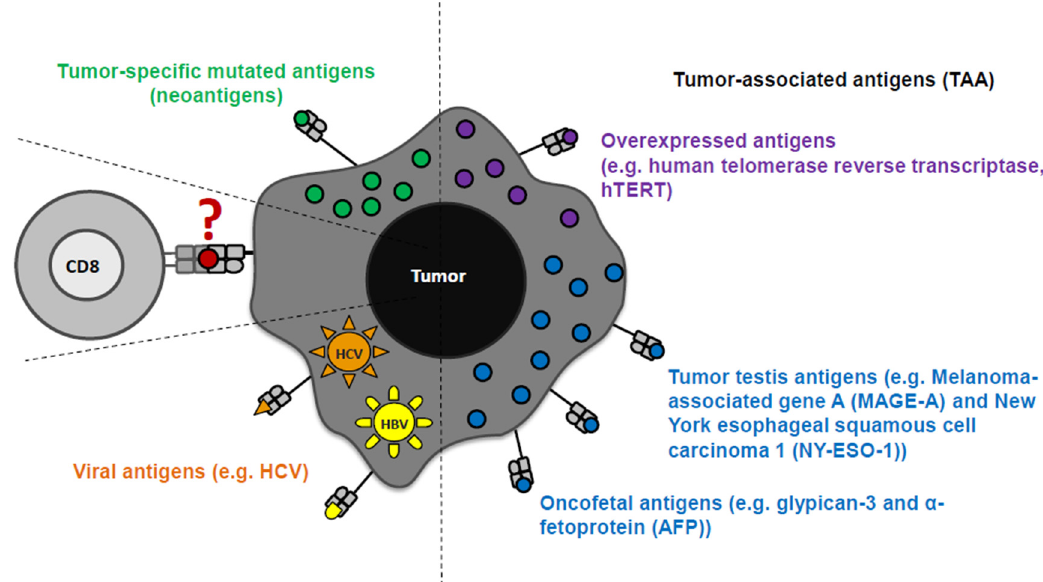
Figure 1. Tumor antigens in the context of hepatocellular carcinoma (HCC). Tumor-specific antigens (neoantigens), tumor-associated antigens (TAA: overexpressed antigens, tumor testis antigens, and oncofetal antigens), and viral antigens are detectable in HCC patients.